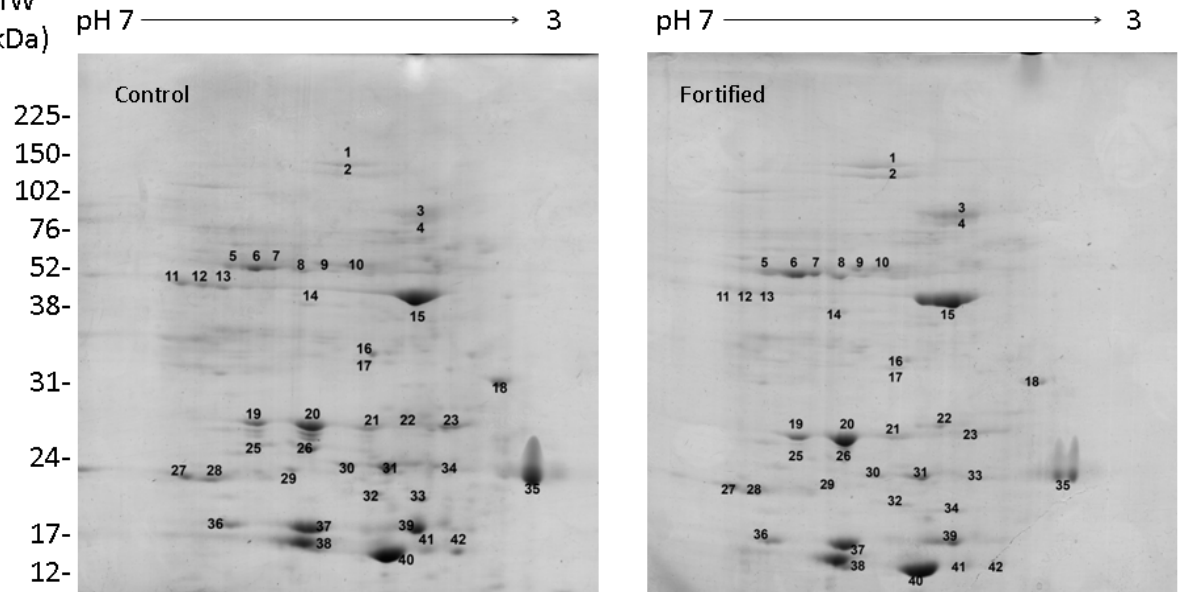
Figure 2. Representative 2D gel images of control and fortified broccoli.